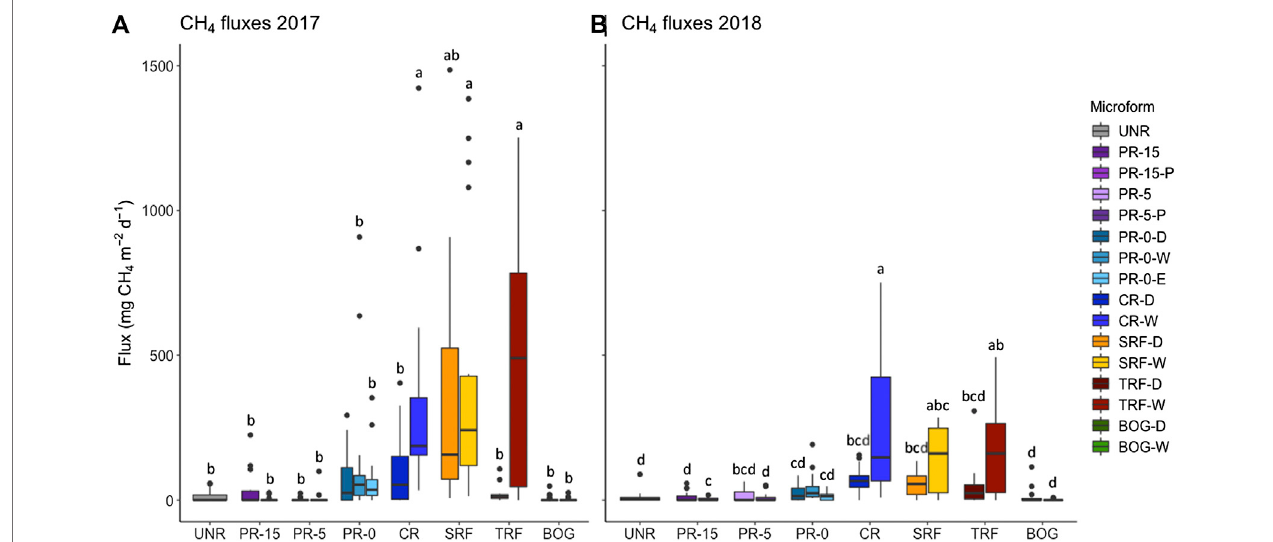
FIGURE7| Measurementsofmeanmethane fl uxes(mgCH 4 m − 2 d − 1 )duringthe107-days-monitoringseasonsin2017 (A) andin2018 (B) .Groupswiththesame letters(inseparateyears)arenotsigni fi cantlydifferent.Microformshowedasigni fi canteffectonCH 4 fl uxesinbothmonitoringyears,2017(F (15,292) (cid:2) 6.75, p < 0.001,adj. R 2 (cid:2) 0.2)and2018(F (15,283) (cid:2) 7.54, p < 0.001,adj. R 2 (cid:2) 0.3).*Restoredsectors:UNR (cid:2) unrestored,PR-15 (cid:2) partialremovalofmineralsoil(MS)to15 cmaboveseasonal water table, PR-5 (cid:2) partial removal of MS to 4 – 6 cm above seasonal water table, PR-0-D/W (cid:2) partial removal of MS to surface elevation of surrounding fen reference ecosystem (uneven ground relief with microforms dry (D) and wet (W), PR-0-E (cid:2) partial removal of MS to near the surrounding fen reference ecosystem (even ground relief), CR (cid:2) complete removal of mineral soil (MS). Reference ecosystem (REF): SRF (cid:2) shrubby extreme-rich fen; TRF (cid:2) treed rich fen, BOG (cid:2) wooded bog.